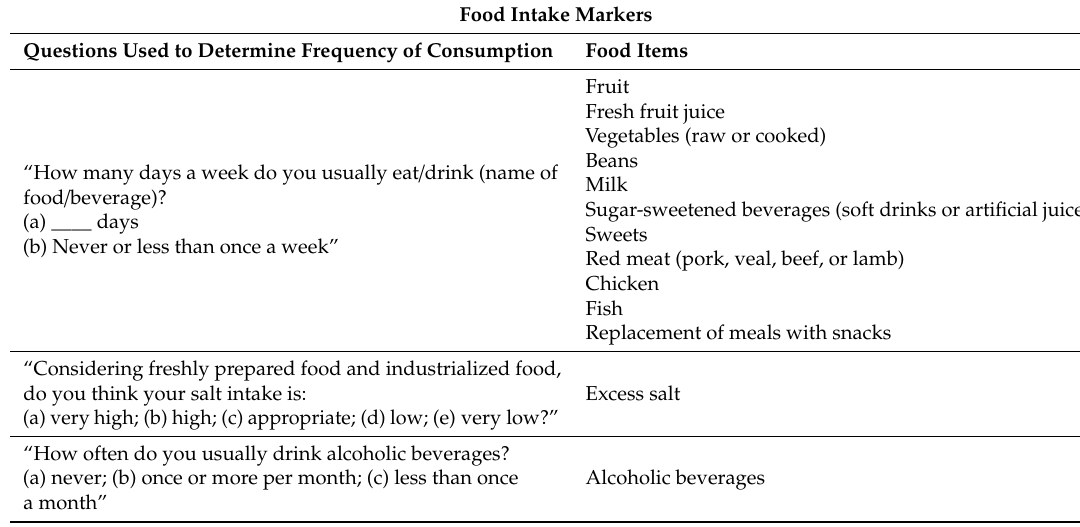
Table 1. Food intake markers evaluated in the study and determination of frequency of